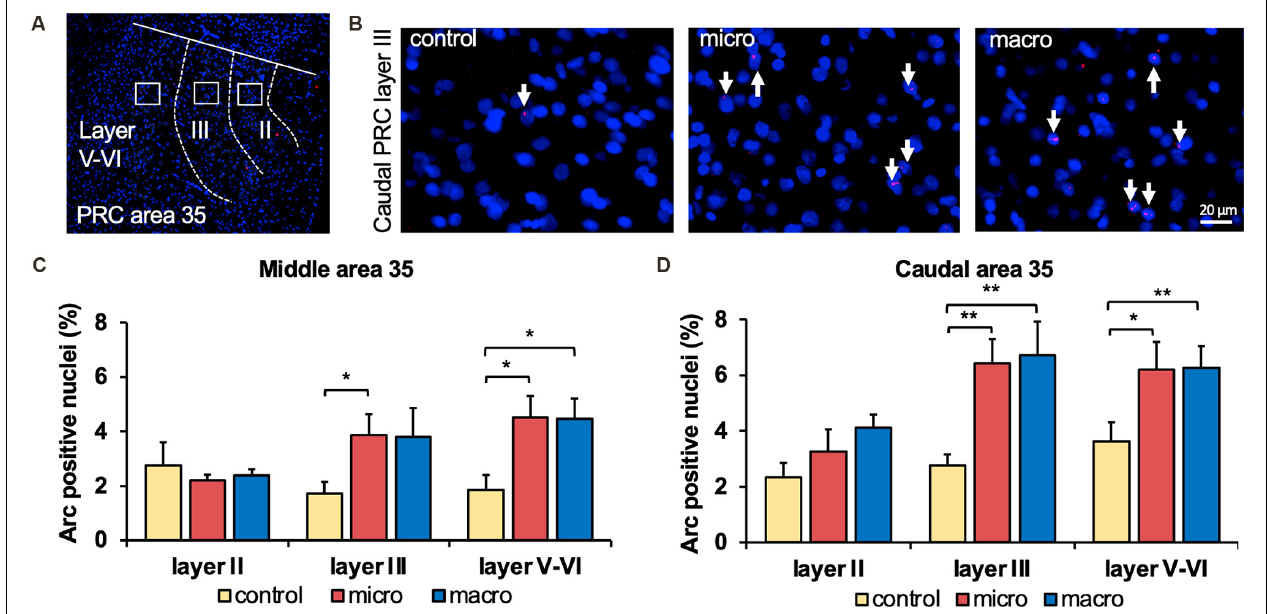
FIGURE 2 | Exposure to novel microscale or macroscale items significantly enhances nuclear Arc mRNA expression in middle and caudal area 35. (A) Fluorescent image of area 35 showing the superficial layers II and III and the deep layers (separated by white dotted lines), as well as the origin of the representative photomicrographs (white outline). Nuclei were stained with DAPI (blue) and the Arc mRNA signal is shown in red. (B) Photomicrographs showing nuclear Arc mRNA expression (red, indicated by white arrows) in layer III of the caudal area 35 from a control animal (control) and an animal that participated in microscale (micro) or macroscale (macro) item exploration. Blue: nuclear staining with DAPI. Images were taken using a 20x objective. Scale bar: 20 µ m. (C) The relative percentage of Arc mRNA positive nuclei in the middle area 35 of control and the two experimental groups (mean ± SEM) is shown. Novel exposure to microscale items (micro, red bar) triggers a significant increase in nuclear Arc mRNA expression in the superficial layer III and deeper cell layers of the middle area 35 compared to their control group (yellow bar). By contrast, novel exposure to macroscale items (macro, blue bar) significantly elevates nuclear Arc mRNA expression in the deep layers of the middle area 35 compared to control animals (Fisher’s LSD post-hoc test: p < 0.05), whereas a tendency is visible for layer III. No significant differences were observed in layer II of the middle area 35. (D) Relative percentage of Arc mRNA positive nuclei in the caudal area 35 of controls and the two experimental groups (mean ± SEM). The exposure to novel objects, regardless of the different dimensions of the novel items, significantly changes nuclear Arc mRNA in the superficial layer III and the deep layers of the caudal area 35 compared to their controls ( post-hoc test). In layer II a tendency towards a change can be detected after the exploration of macroscale items ( post hoc : caudal control vs. macro p = 0.077845). (C,D) Significant differences for each layer for the experimental groups compared to their control group are marked with asterisks * p < 0.05, ** p < 0.01.